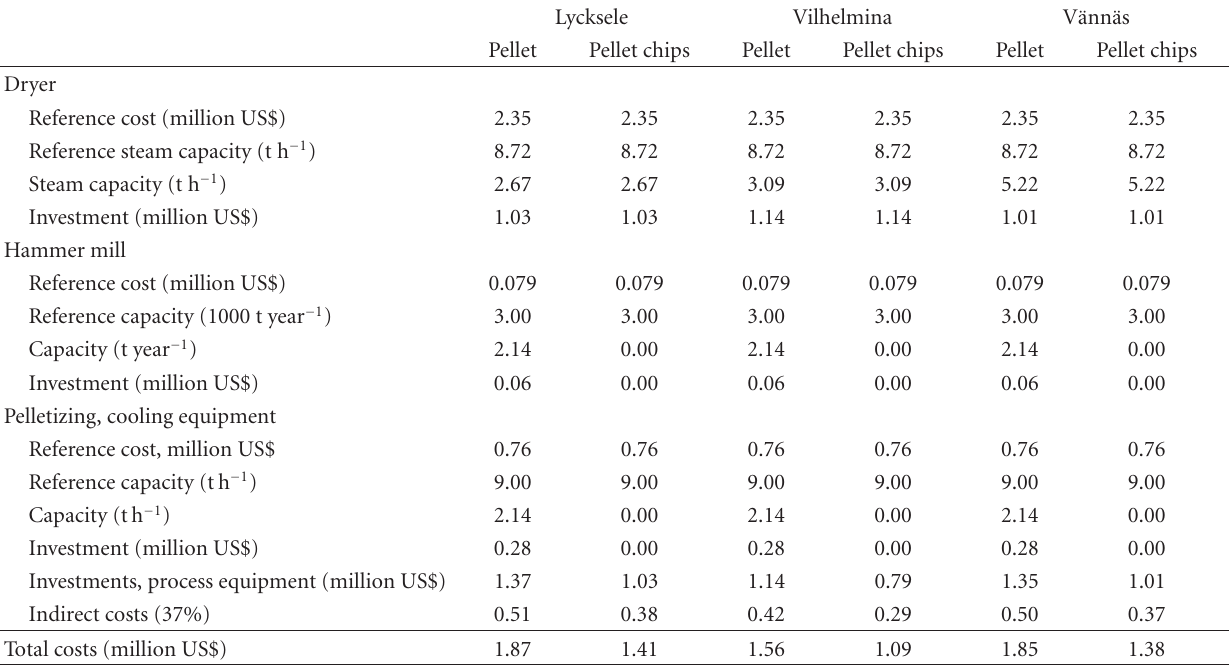
Table 4: Required investments for each of the three plants.